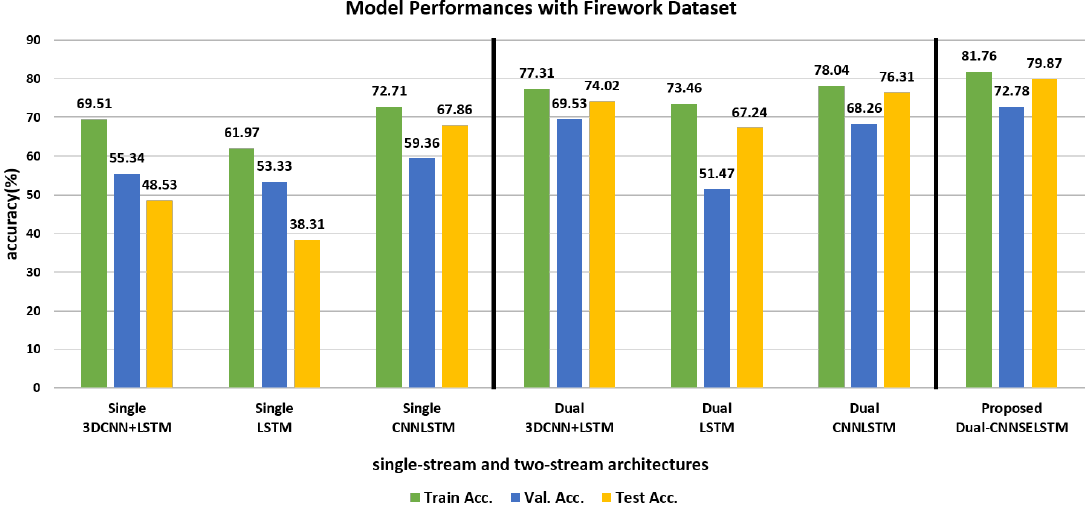
Figure 5. Performance (%) comparison of single-stream network and two-stream network architectures with the proposed Dual-CNNSELSTM model.